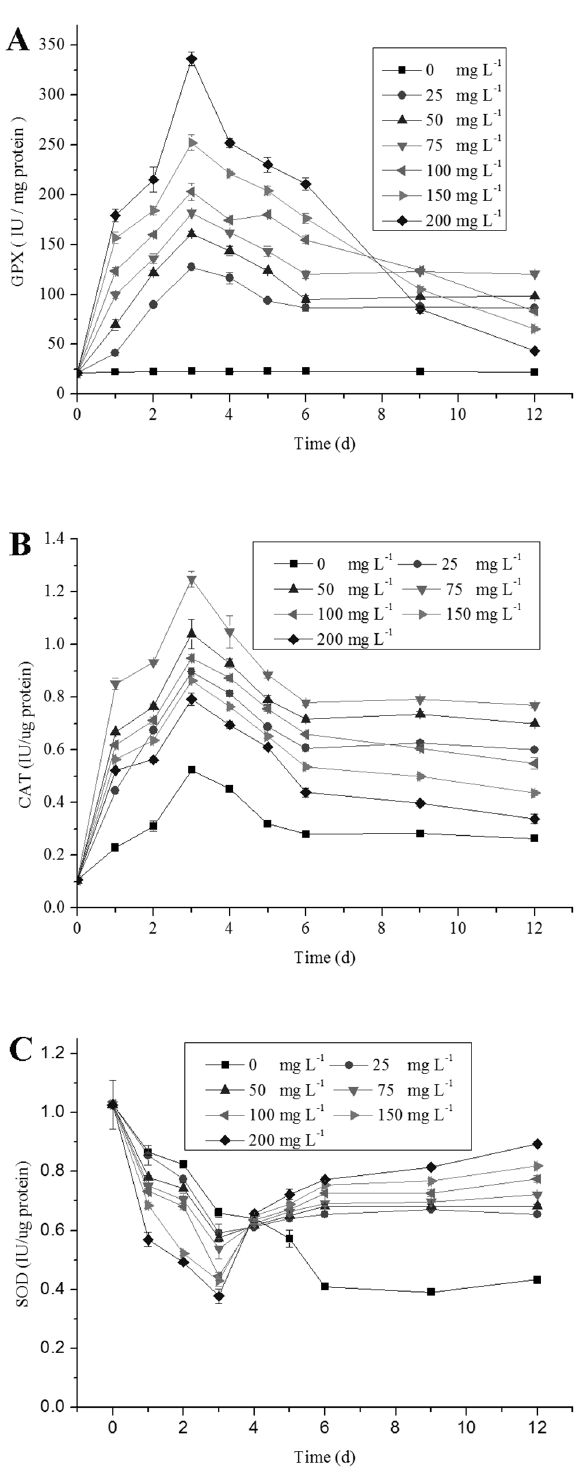
Figure 4. Changes in antioxidant enzyme activities of C.vulgaris during cultivation time at different Se concentrations. (A) GPX, (B) CAT, (C) SOD. Values expressed are means 6 SD of three replicates.